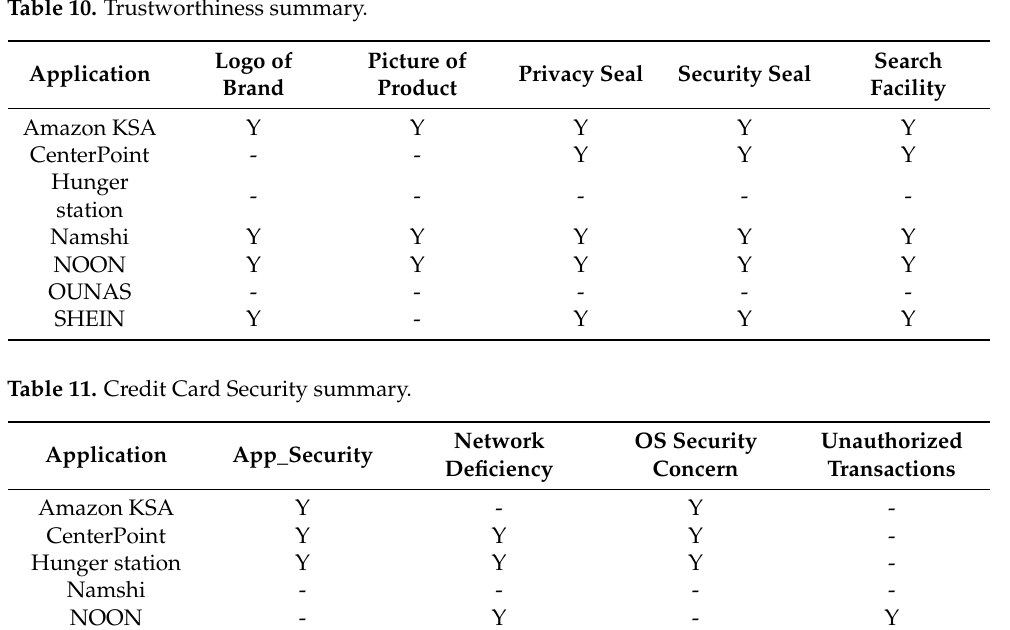
Table 10. Trustworthiness summary.